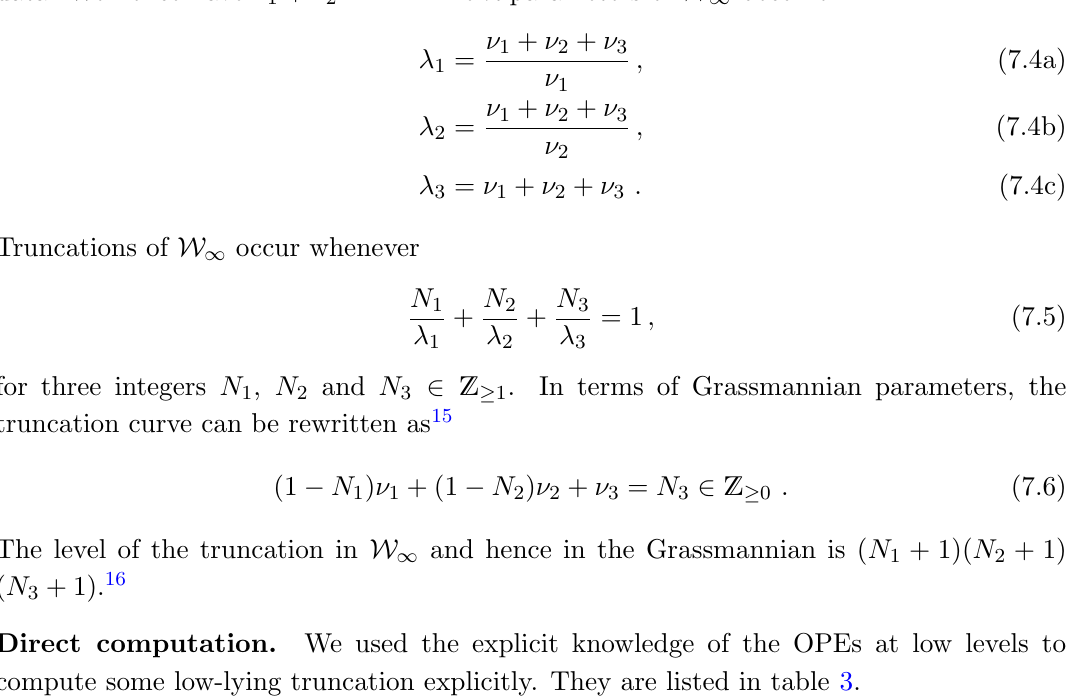
Table 3 . Low-lying truncation curves. These are directly extracted from the OPEs. It is understood that all the triality images of the truncation also appear. We added comments on the truncation curves which indicate how they can be understood from the di(cid:11)erent inputs we have given above. the (cid:22) truncation curve with another truncation in the Grassmannian, this gives us further 3 data. We hence have (cid:23) + (cid:23) = (cid:0) 1. The (cid:21) -parameters of W 1 2 1